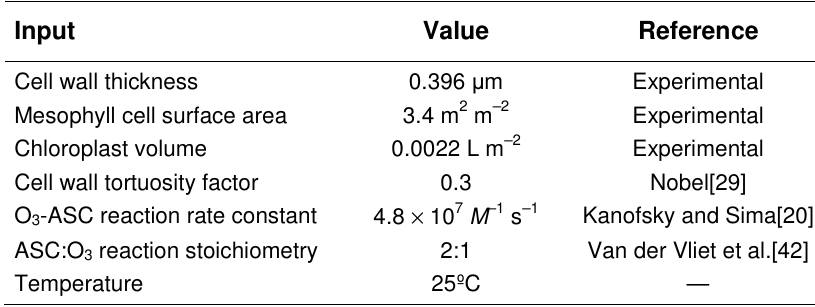
Standardized Input Values